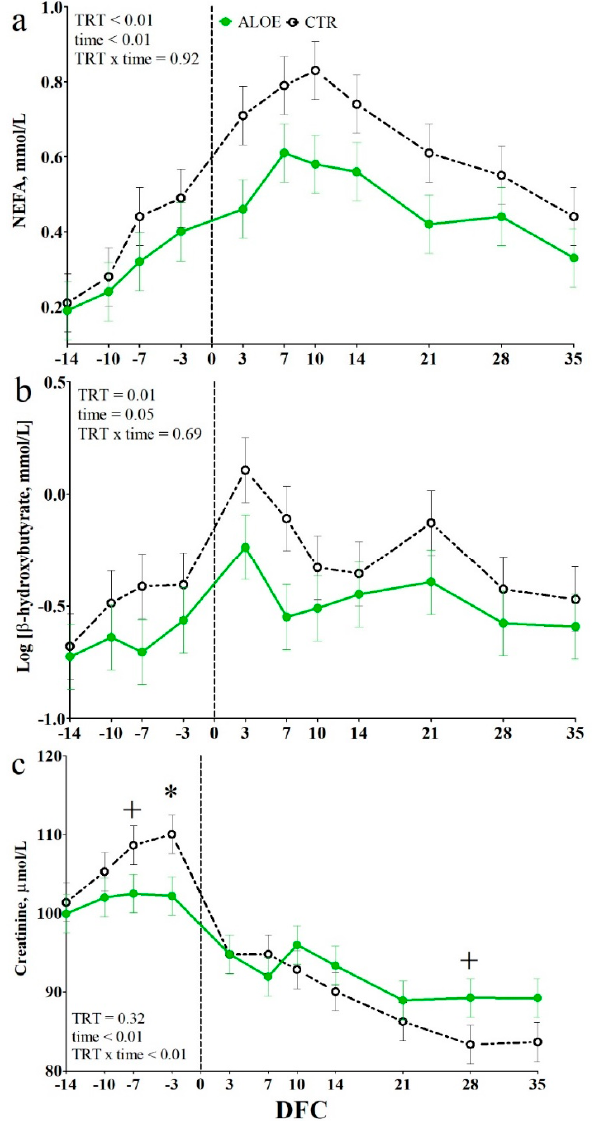
Figure 3. Time course of plasma concentrations of non-esterified fatty acids. NEFA ( a ), beta-hydroxybutyrate ( b ), and creatinine ( c ) in dairy cows receiving placebo water (CTR; black dotted line) or cows receiving a drench of 200 g/d of Aloe arborescens Mill . whole plant homogenate between − 14 and 14 days from calving (AAM; green solid line). * is p < 0.05; + is p < 0.1; Log indicates data expressed as log-transformed; DFC is days from calving.